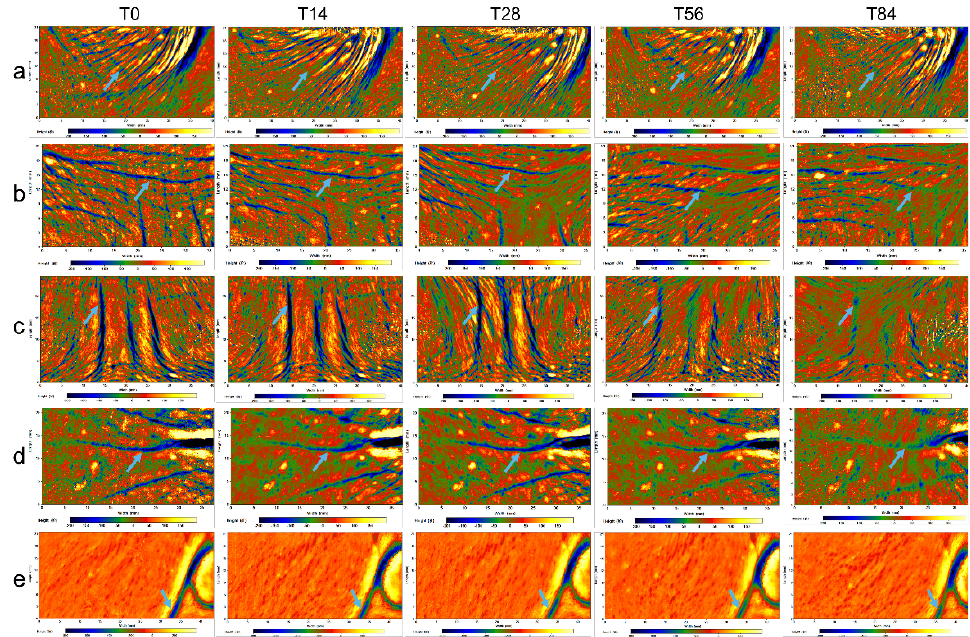
Figure 6. The color-coded 3D images of under-eye fine lines ( a ), forehead lines ( b ), eyebrow lines ( c ), crow’s feet ( d ), and nasolabial folds ( e ) with continuous administration for 84 days.